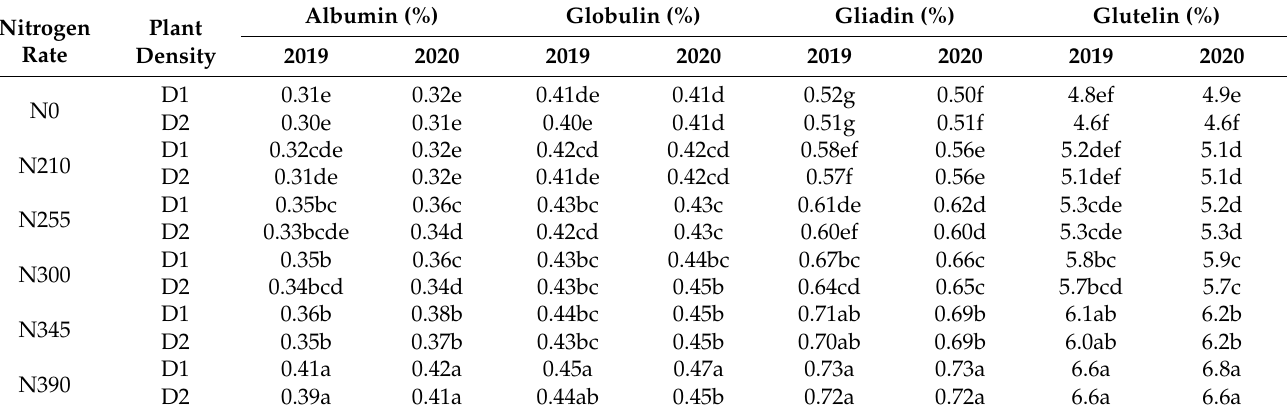
Table 7. Protein content in rice under combined nitrogen rate and planting density in saline